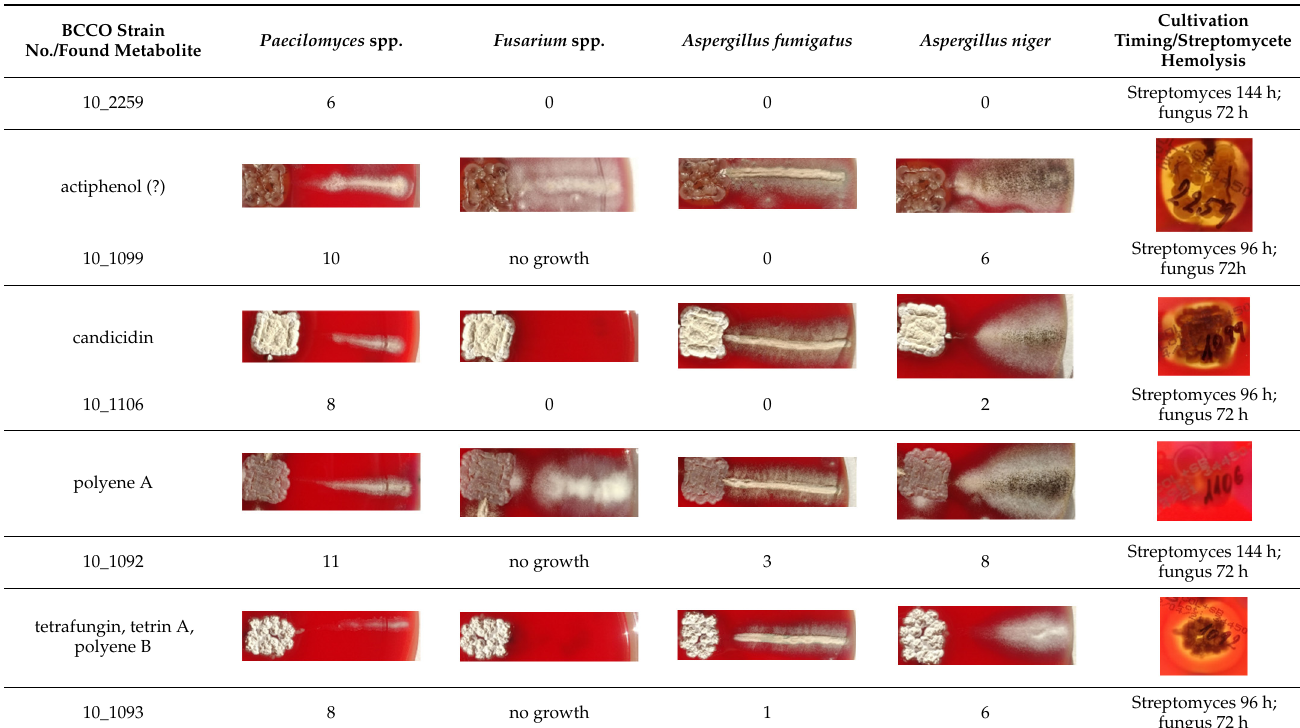
Table 4. Inhibitory activity of Streptomyces spp. against filamentous fungi. Streptomycetes were inoculated in a square shape and the fungi were inoculated in lines. The size of the observed inhibitory zones is presented in mm above each picture. Pictures of hemolytic zones of streptomycetes were taken from the bottom of the dishes.